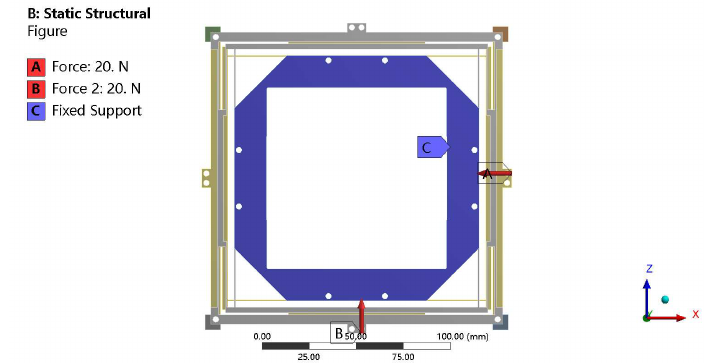
Figure 7. Analysis settings of finite-element simulation study.